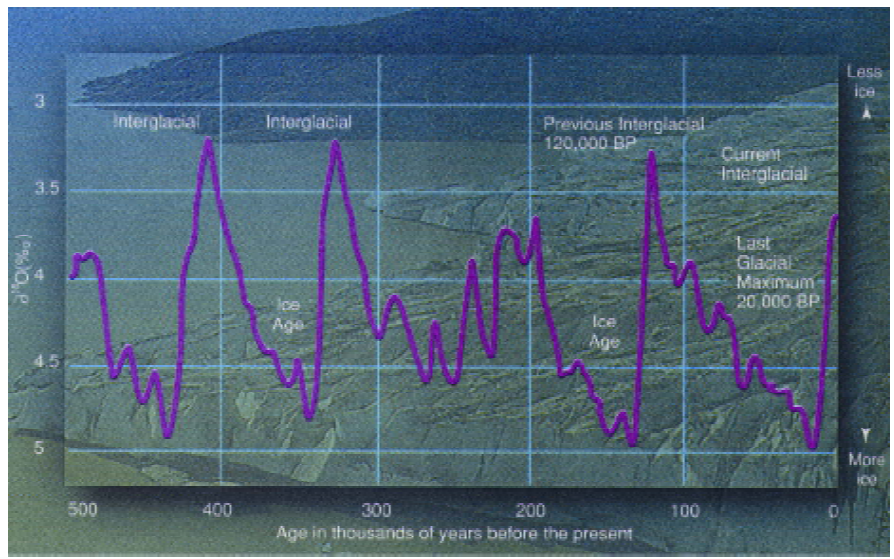
FIGURE 7. Variation in mass of global ice in continental ice sheets from marine sediment oxygen isotope records. Note plot is upside down to show warm periods at top and cold at bottom. (Taken from NOAA reports to the Nation, No. 4, Fall